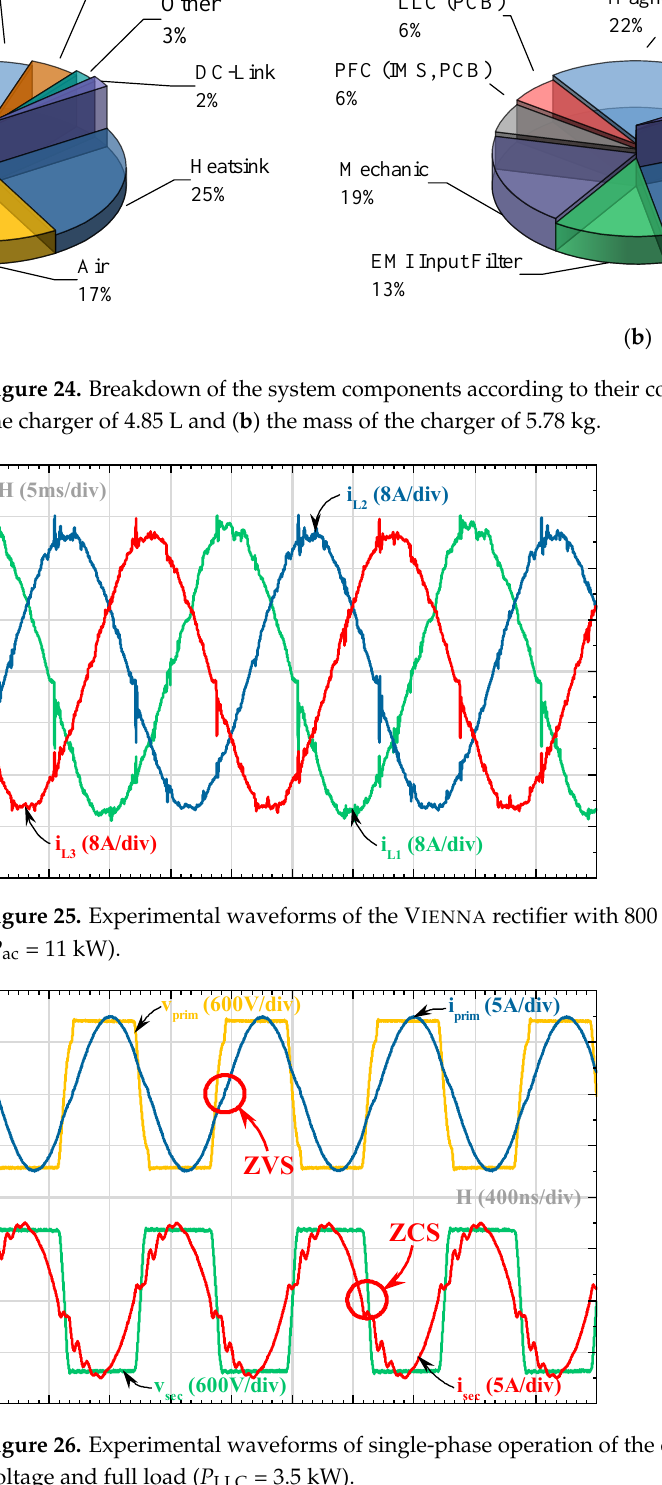
Figure 26. Experimental waveforms of single-phase operation of the dc/dc stage with 800 V battery voltage and full load ( P LLC = 3.5 kW).